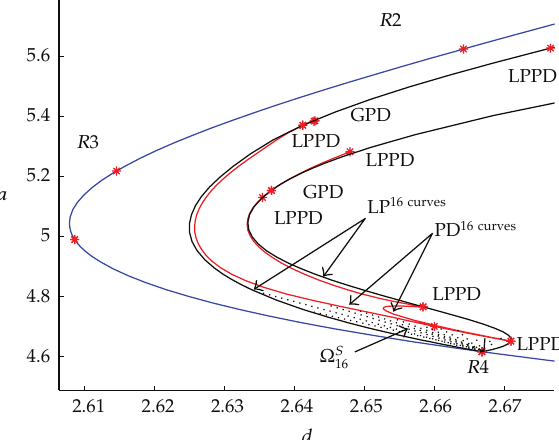
Figure 15: Stability region Ω 16 S of the 16-cycle C 16 . The boundaries consist of LP 16 and PD 16